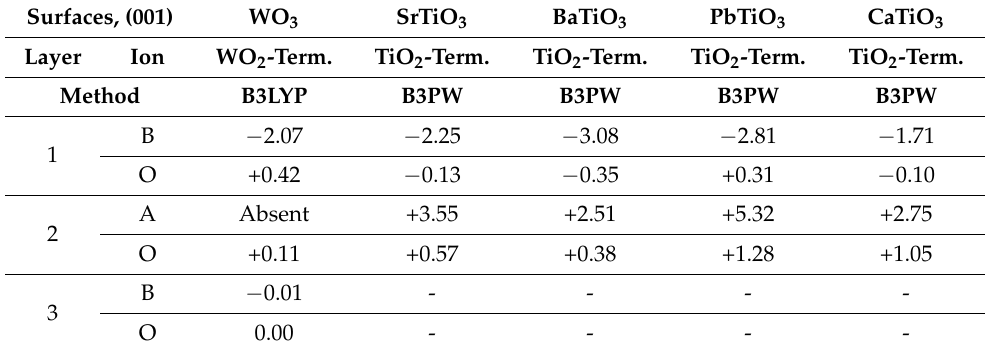
Table 5. WO 2 -terminated WO 3 as well as TiO 2 -terminated SrTiO 3 , BaTiO 3 , PbTiO 3 and CaTiO 3 (001) surface atom relaxation for upper-three surface layers (in percent of the bulk lattice constant).